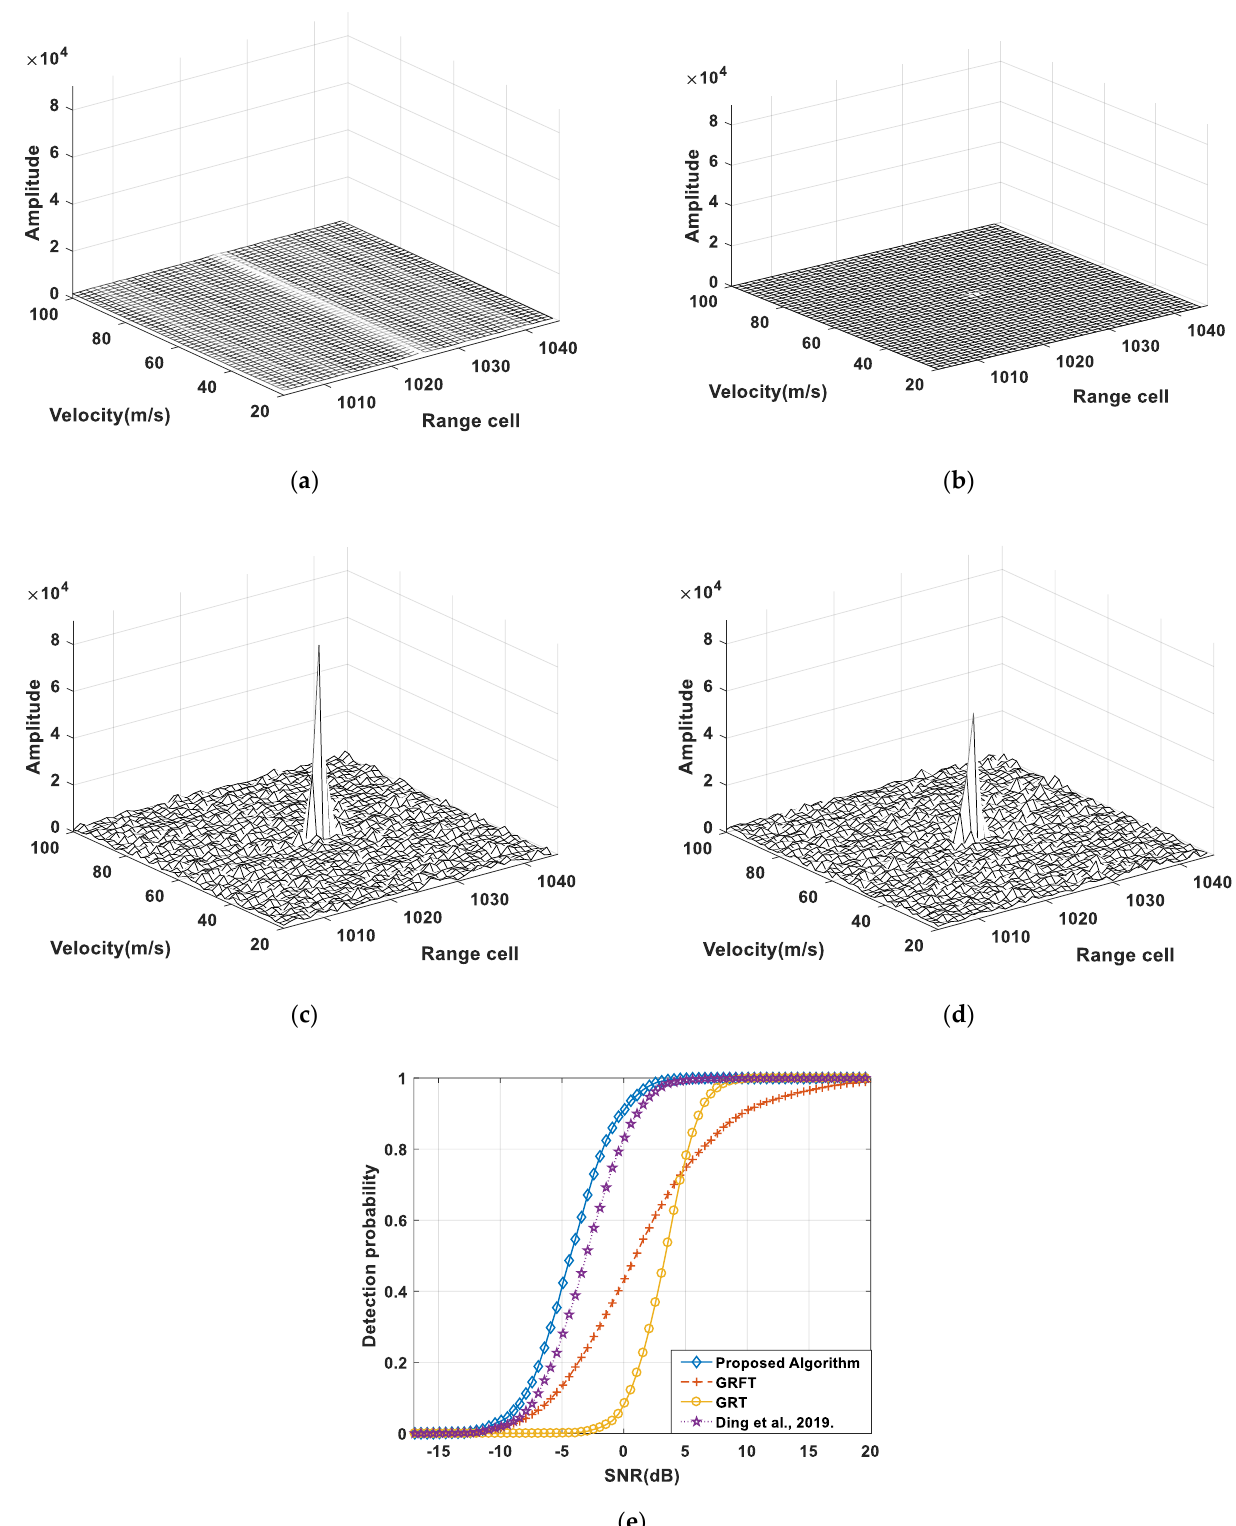
Figure 6. Simulation results in case 1. ( a ) Integration result via GRT; ( b ) Integration result via GRFT; ( c ) Integration result via the proposed method; ( d ) Integration result via MTD-GRT [47]; ( e ) Detection performance for four integration methods